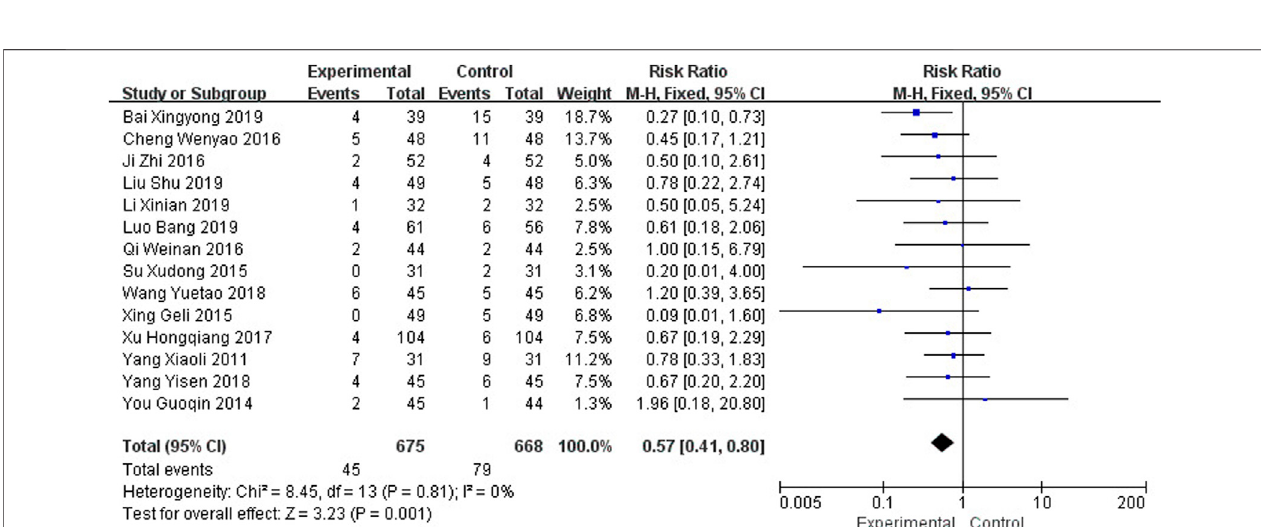
FIGURE 11 | Meta-analysis of adverse events.